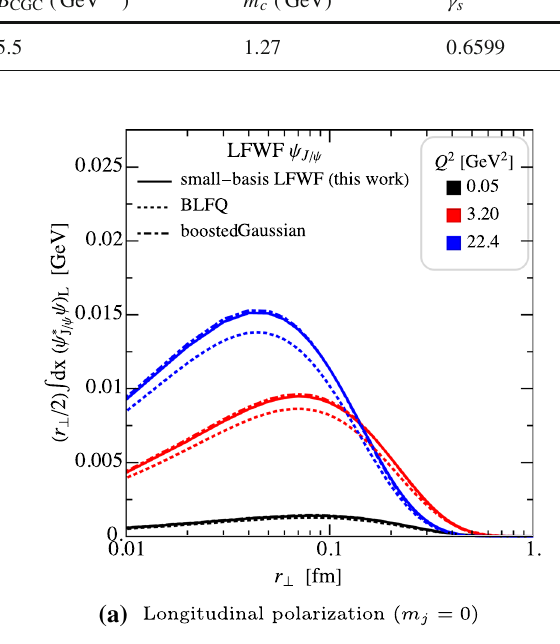
Table 8 Parameters of the bCGC model in Eq. (73) determined from fits to combined HERA data [83] B CGC (GeV − 2 )